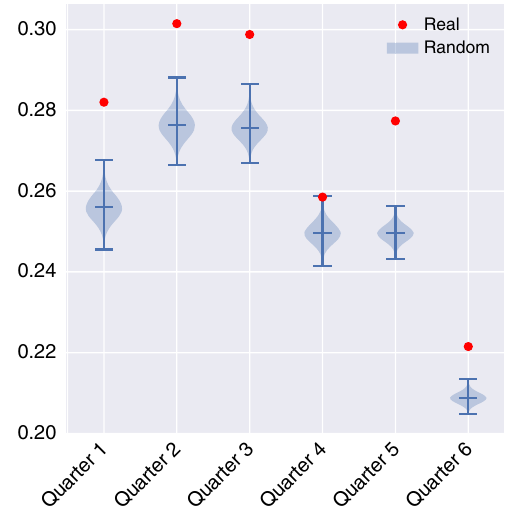
Fig. 4 Comparison of the observed balance in the system, b t to the expected ^ b t (CI is shown) in each time period indicates that the observed system is in a greater state of balance than would be expected in a comparable randomized network